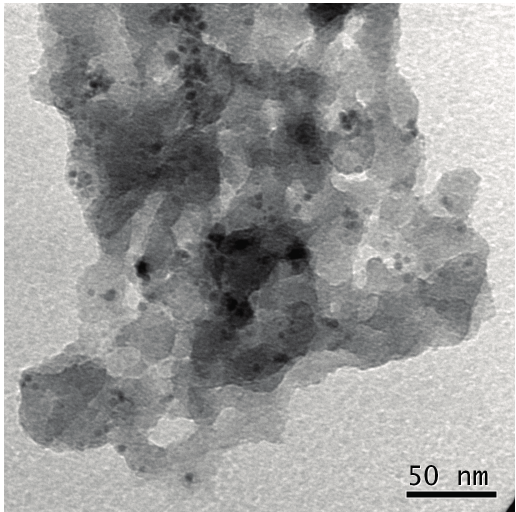
Figure 3. TEM bright field image of the pristine catalyst slice with Pd NPs describing the sponge-like nanostructure of the polymer